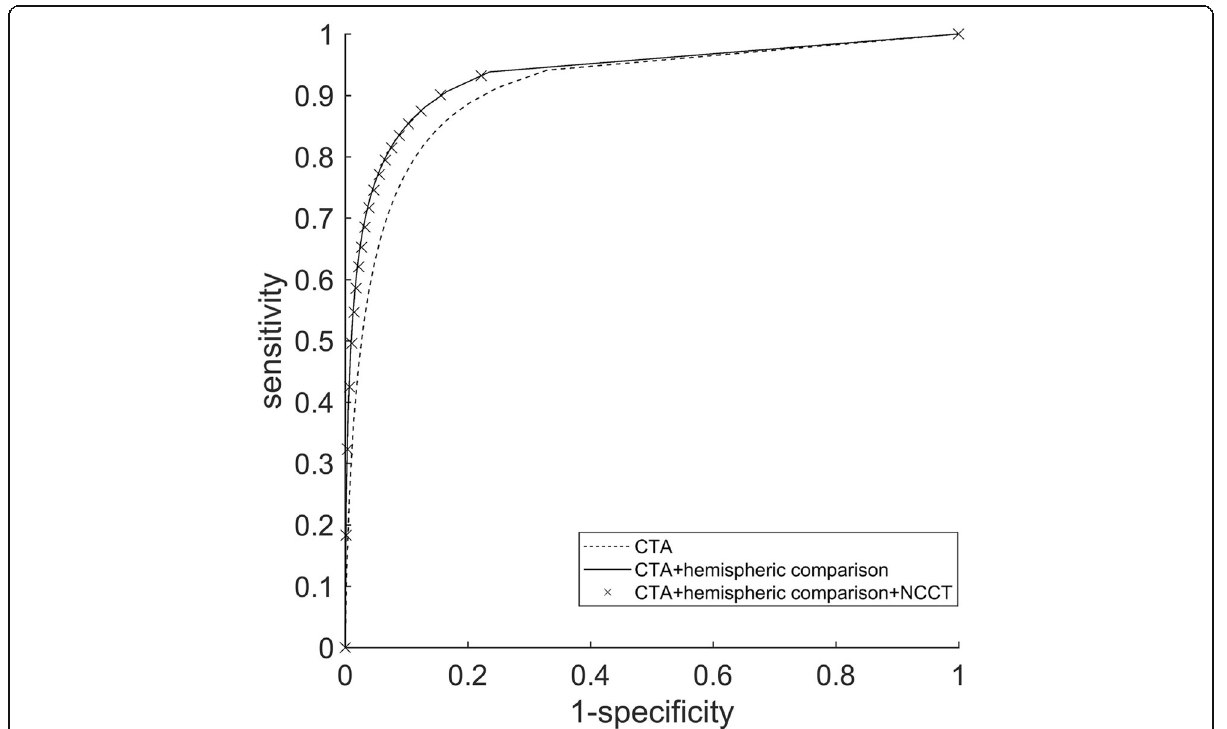
Fig. 4 Voxel-wise receiver operating characteristic curves over the whole testing set were calculated for the three trained CNNs by varying the threshold value of the produced probability maps. An increase in performance can be seen when cerebral hemispheric comparison CTA was included in the CNN analysis